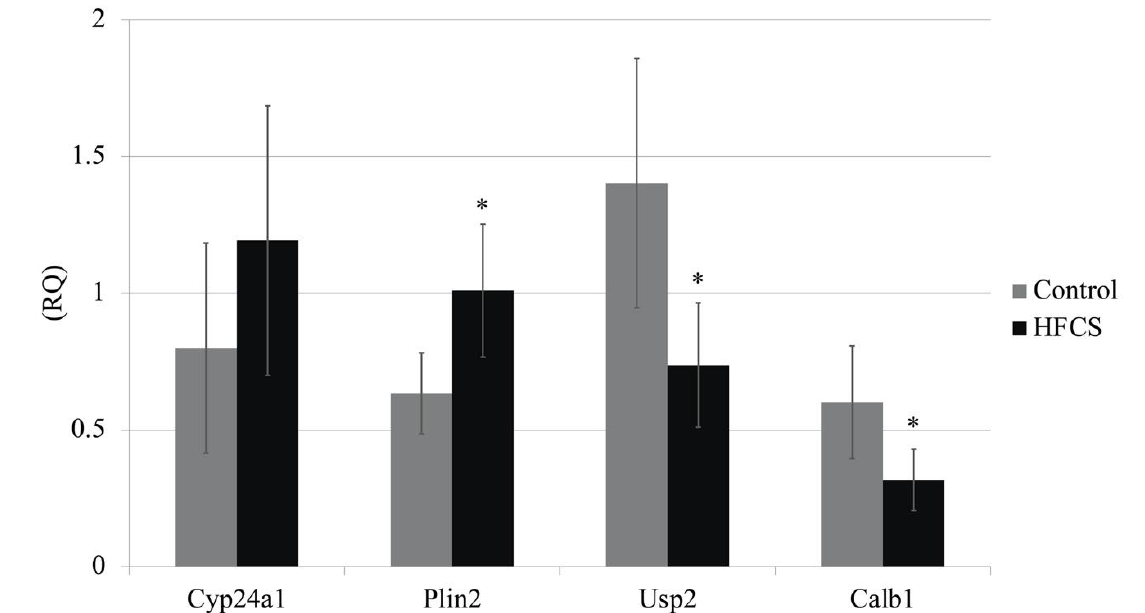
Figure 4. mRNA expression of Cyp24a , Plin2 , Usp2 , and Calb1 genes in Wistar rat kidneys from the high-fructose corn syrup (HFCS) and control groups. Expression levels of the target genes were normalized to those of β-actin ( n = 10 per group). * p < 0.05 HFCS versus control group (Mann-Whitney U -test). RQ, relative quantification by real-time polymerase chain reaction.